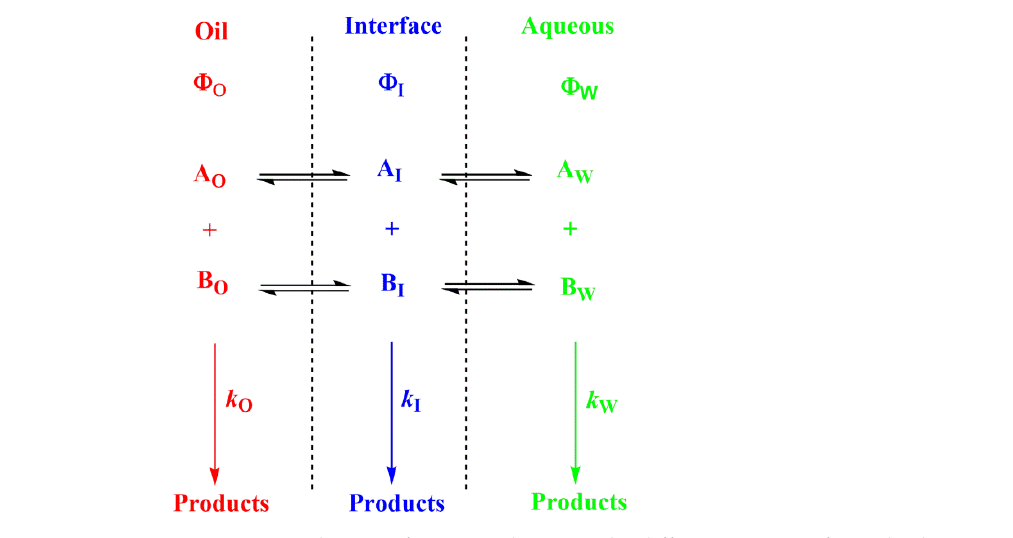
Figure 6. Distribution of reactants between the different regions of a multiphasic system, such as a microemulsion. Φ and k stand for the volume fraction in each particular region and for the second order rate constant for the reaction between A and B in each region, respectively (O–oil, I—interfacial and W—aqueous regions).